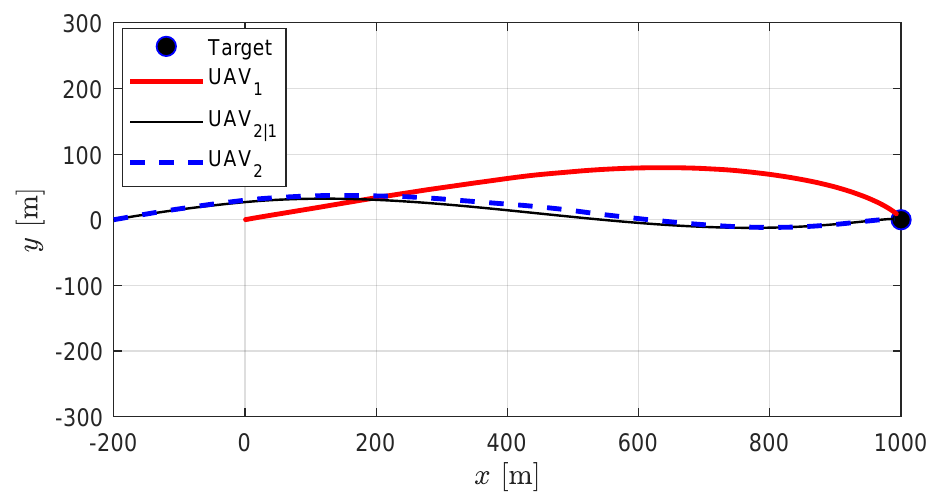
Figure 5. Decentralized cooperation: UAV trajectories. Thin black line represents UAV 1 ’s best estimate on UAV 2 ’s position, and the dotted blue line represents the actual trajectory of UAV 2 . Table 3. Results from the decentralized cooperation with information constraints.